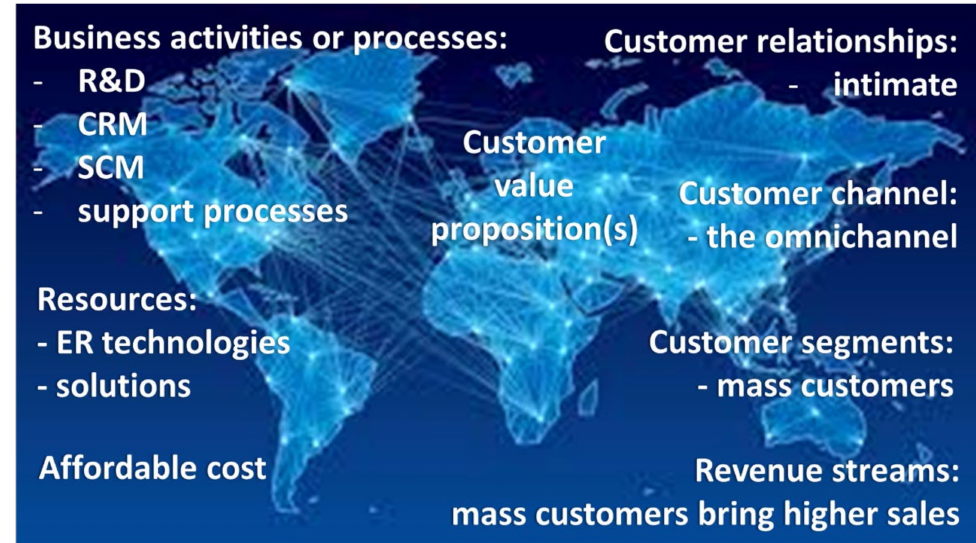
Figure 3. ER enables customer pull in delivery models and business